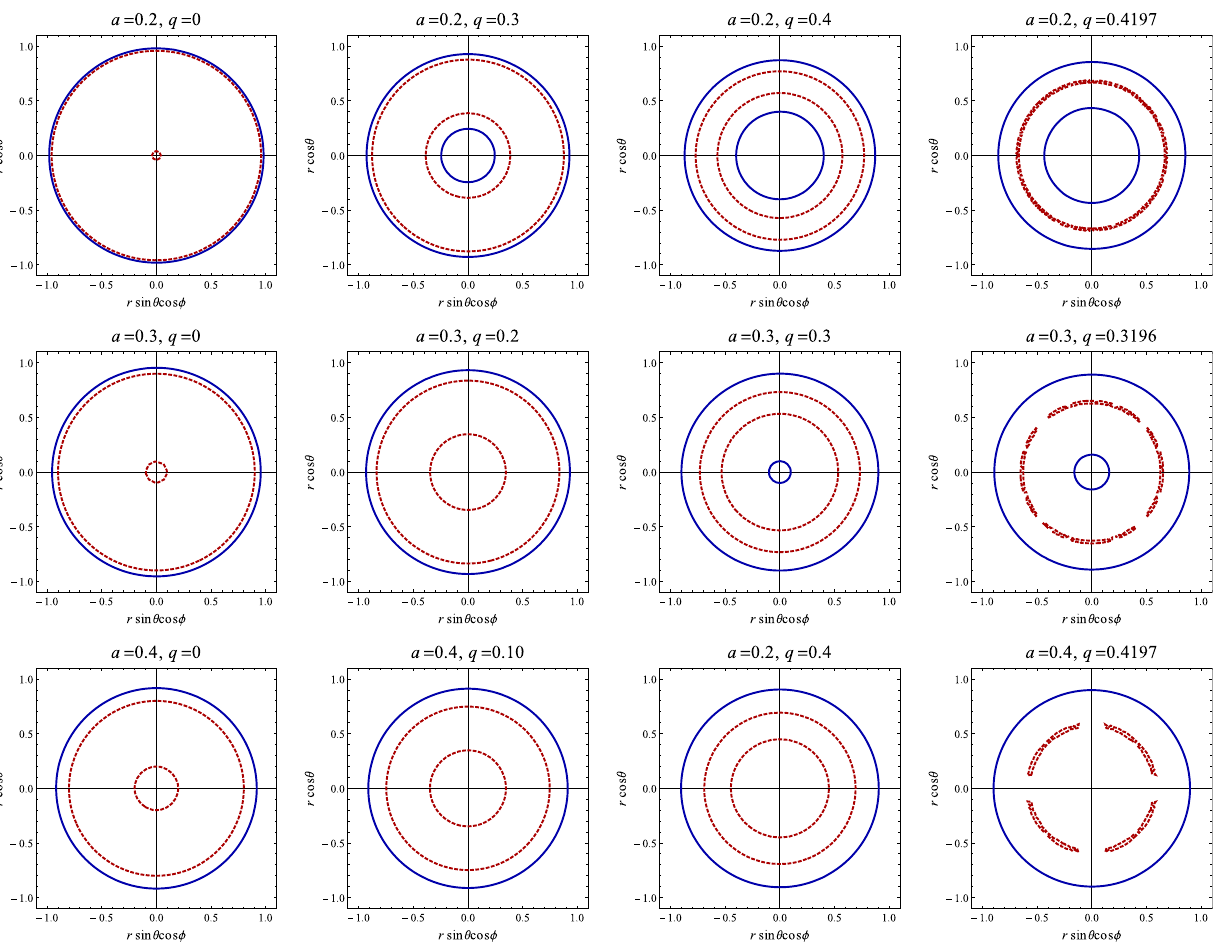
Fig. 2 The cross section of the event horizon, static limit surface, and ergoregion for different values of q with a fixed value of rotation param- eter a for the five-dimensional EMCS black hole; the case q = 0 refers